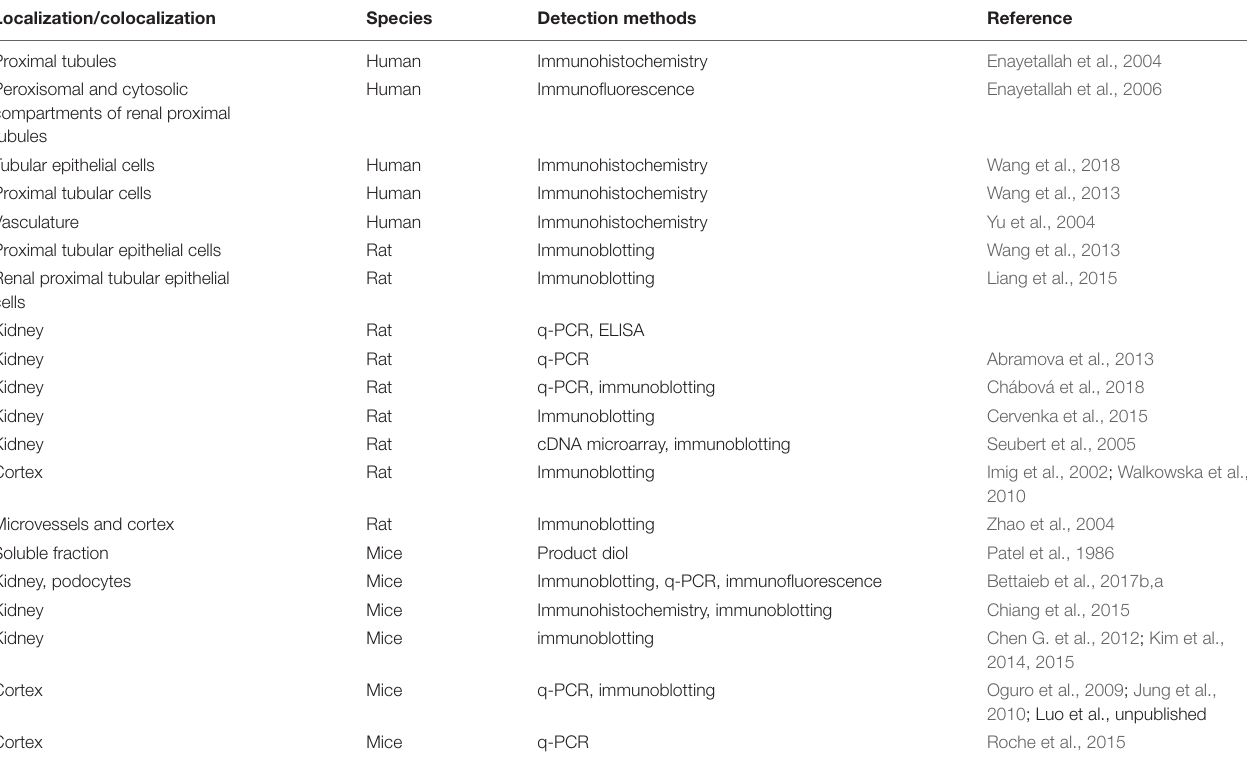
TABLE 1 | The location and co-location of sEH in kidneys from different